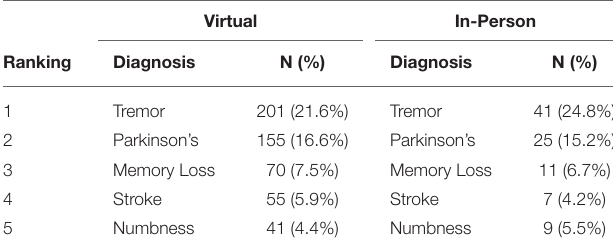
TABLE 4 | Imaging volume by visit